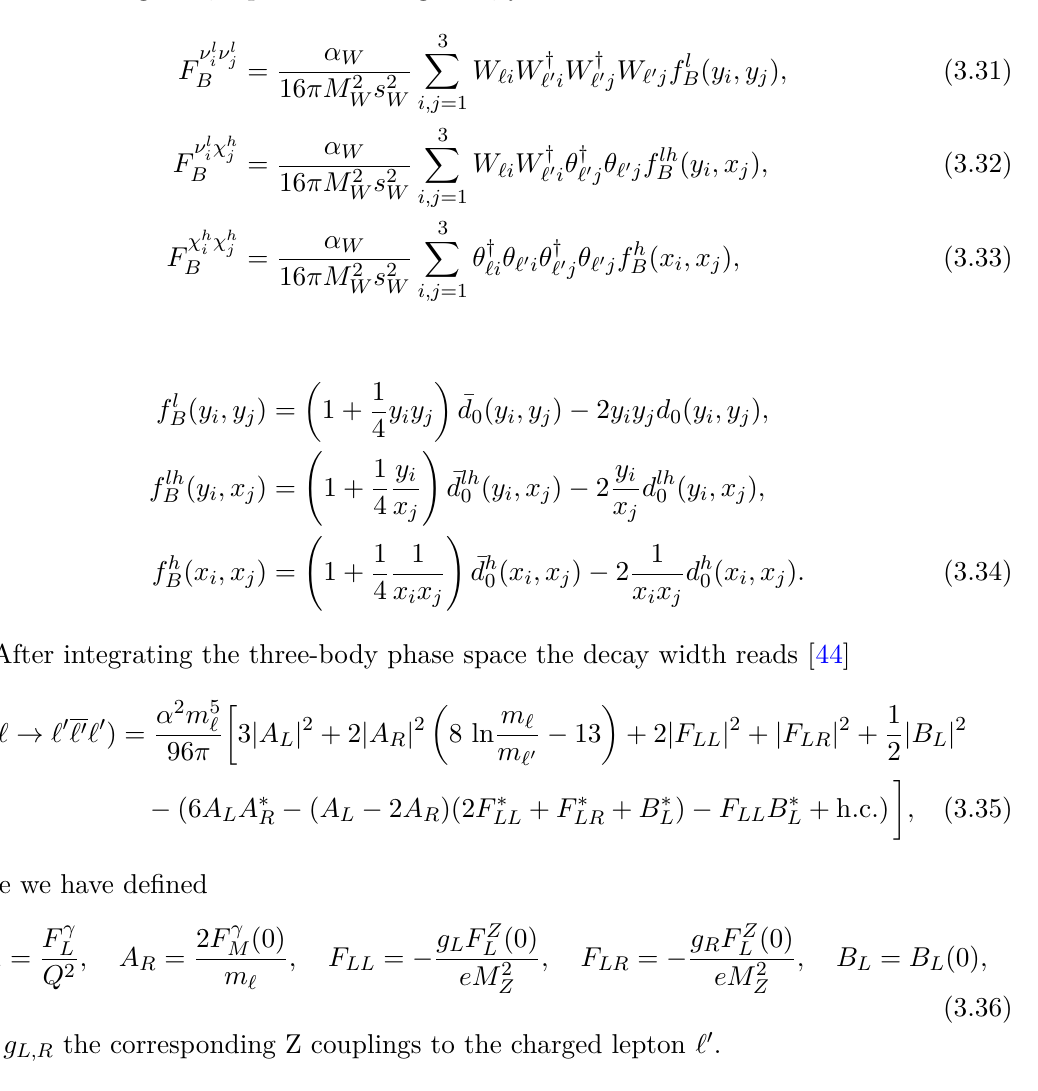
Figure 3 . Box diagrams contributing to Type I and II ‘ → ‘ 0 ‘ 00